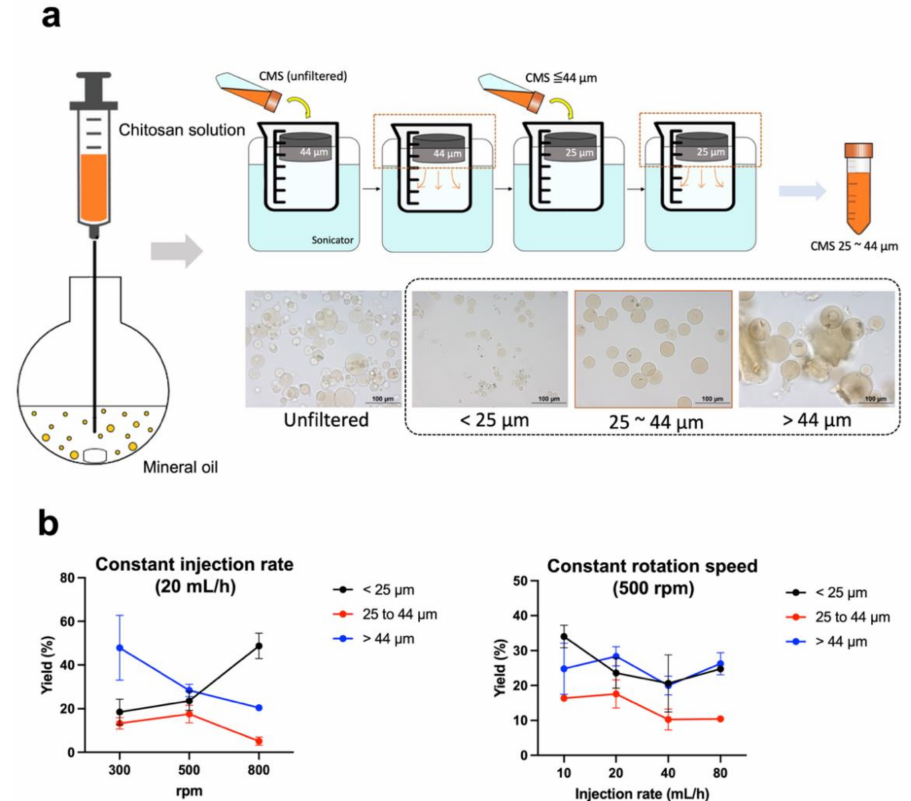
Figure 1. Preparation and physical characterization of chitosan microspheres. ( a ) Schematic diagram of the chitosan preparation process. After filtration by sieves, the microscopic images demonstrated that the CMS with inappropriate size have been excluded. Only the CMS having a size ranging from 25 to 44 µ m were used in the following experiments. ( b ) Chemical yields of chitosan microspheres using different rotation speeds and injection rates. Unfiltered: crude product; <25 µ m: smaller-sized CMS; >44 µ m: larger-sized